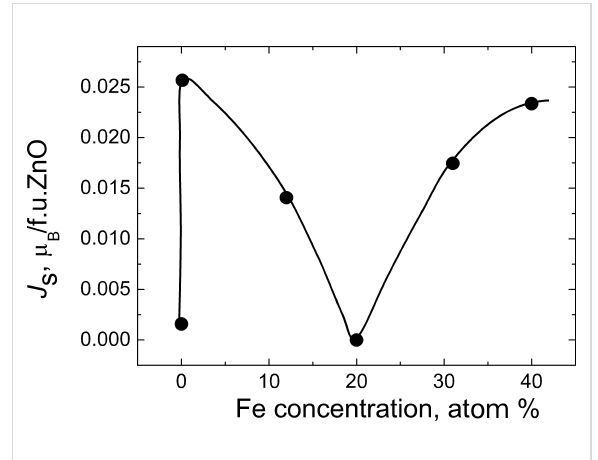
Figure 3: Dependence of the saturation magnetization J s (magnetic moment in units of Bohr magnetons per ZnO formula units) on the Fe concentration in ZnO nanograined polycrystals obtained by the “liquid ceramics”